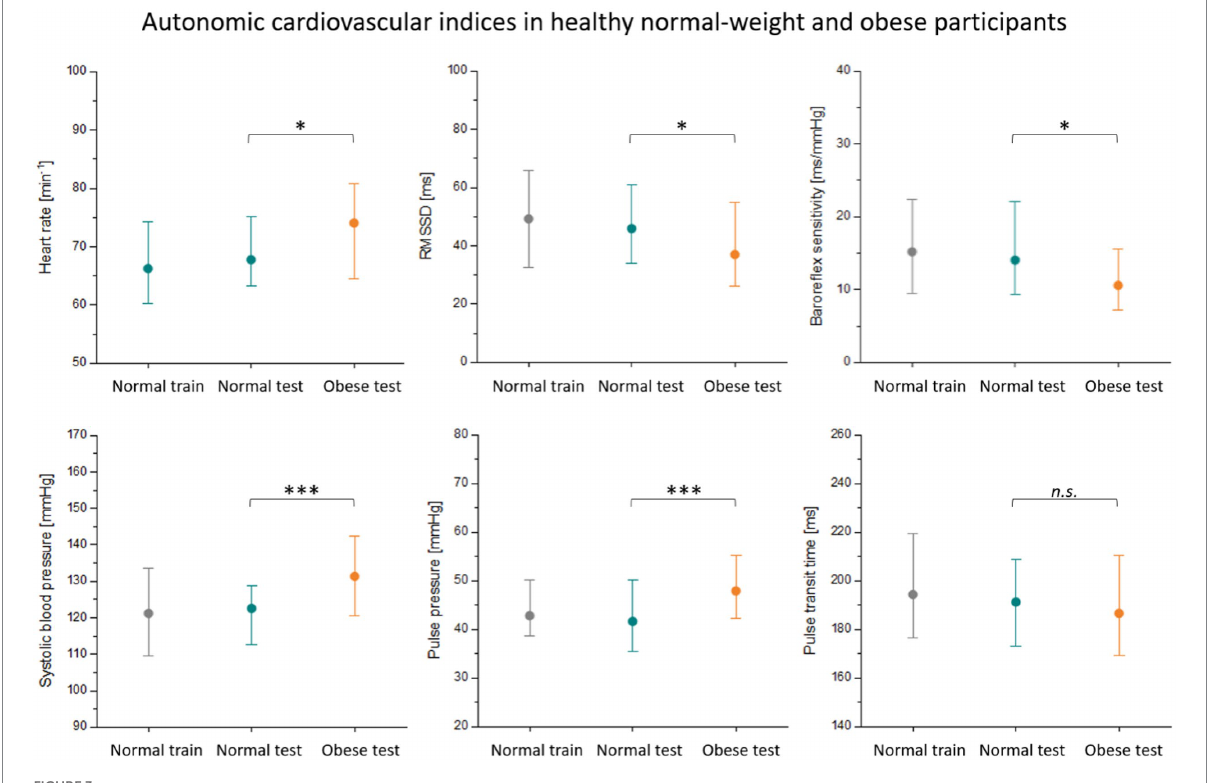
FIGURE 3 Autonomic cardiovascular indices in two subsets of normal-weight participants (training data in gray, test data in cyan) and obese participants (orange). The median is depicted together with the lower quartile and the upper quartile. The two test sets were compared using the Wilcoxon rank-sum test with p -values indicated in the figure [ p < 0.05 (*); p < 0.001 (***); p > 0.05 (n.s.)]. RMSSD, vagal heart rate variability (root-mean-square of successive heart beat intervals).